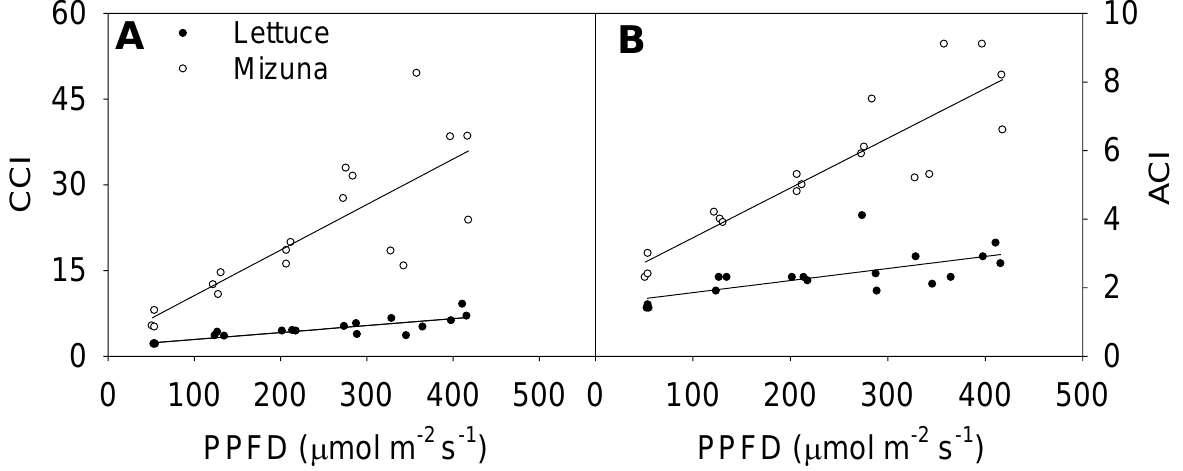
Figure 4. ( A ) Chlorophyll content index (CCI) and ( B ) anthocyanin content index (ACI) of mizuna ( Brassica rapa var. japonica ) and lettuce ( Lactuca sativa ‘Green Salad Bowl’) plants grown at six different photosynthetic photon flux densities (PPFD). Data were collected a day before the harvesting (26 and 27 days for mizuna and lettuce, respectively). Lines show the results from multiple regression analysis, which indicated a significant species × PPFD interaction for both CCI ( R 2 = 0.82, interaction P < 0.0001) and ACI ( R 2 = 0.88, interaction P < 0.0001).